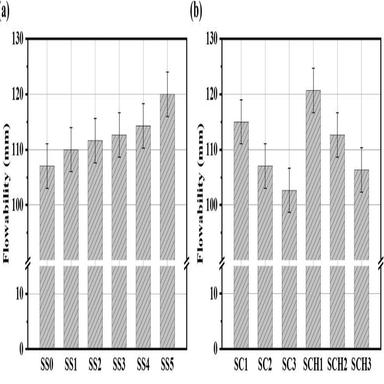
Flowability test results: (a) Flowability of group 1; (b) Flowability of group 2.